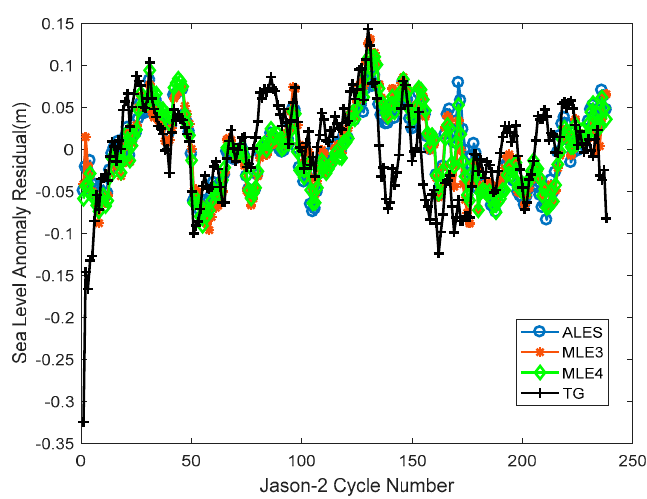
Figure 12. Detrended and deseasoned SLA time series based on ALES, MLE3, and MLE4, with 3-month smoothing (tide gauge SLA—noted TG—is shown as reference). Table 6. Deseasoned and detrended SLA standard deviation w.r.t. tide gauge sea level (cm) for case 1.